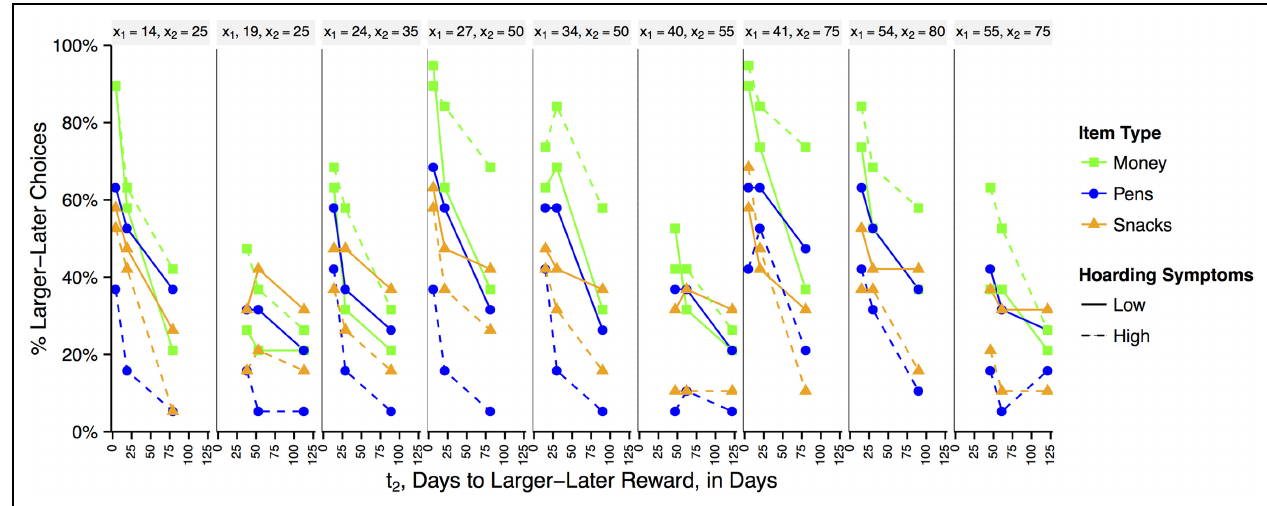
FIGURE 2 | Intertemporal discounting responses for effects of delay and moderate reward amounts with a fixed initial time (now). The percent of participants choosing the LL option overall split by smaller-sooner (x 1 ) and larger-later (x 2 ) reward amounts, which are listed above plots. Choices for money are represented with green lines, pens in blue, and snacks in orange. Low hoarding individuals are represented by solid lines and high hoarding individuals are represented by dashed